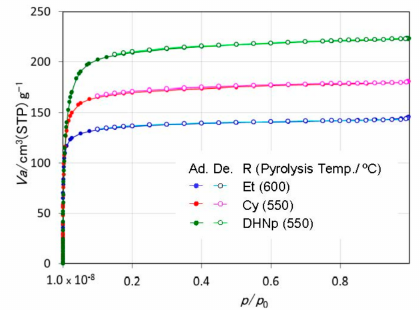
Figure 8. Ar sorption isotherms of ROSZ-derived amorphous Si–O–N samples.